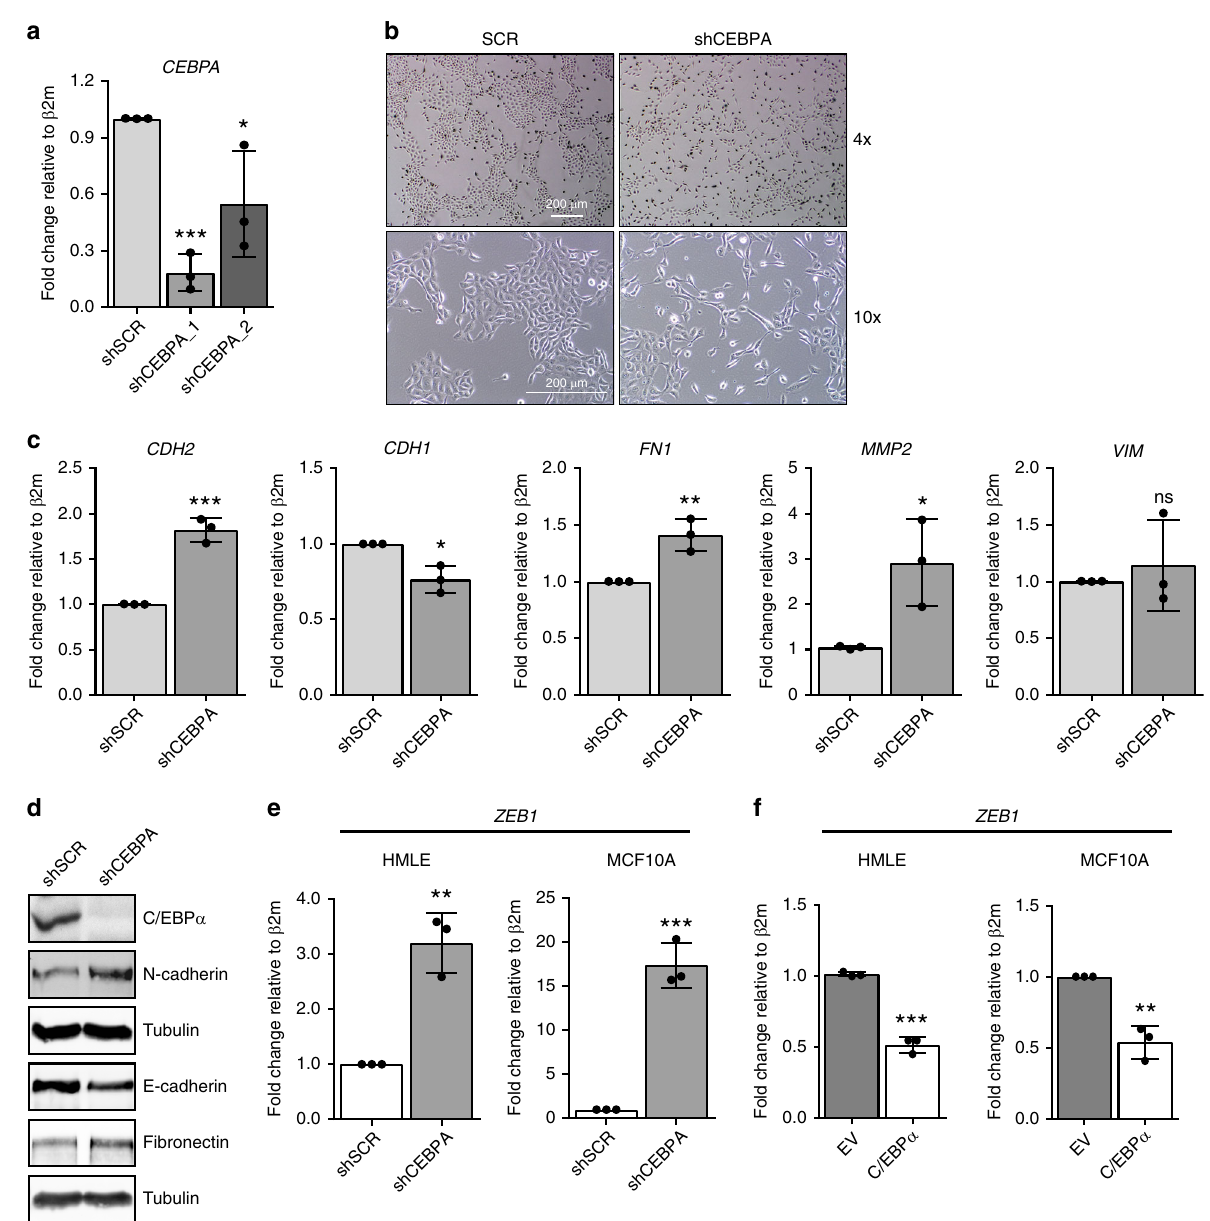
Fig. 5 Knockdown of C/EBP ɑ impairs epithelial homeostasis. a The results from qRT-PCR analysis showing CEBPA mRNA levels in HMLE cells expressing shRNA control (SCR) or HMLE cells expressing two independent shRNAs targeting CEBPA (shCEBPA_1 and shCEBPA_2). Data represented as mean ± SD of three independent experiments. p -values were calculated using unpaired two-tailed Student ’ s t test. * p < 0.05, *** p < 0.001. b Bright- fi eld microscopy images of HMLE cells expressing shRNA control (SCR) or shRNA targeting CEBPA in two different magni fi cations. Data are representative of three independent experiments. Scale bar: 200 μ m. c qRT-PCR data showing the expression levels of known epithelial and mesenchymal markers upon CEBPA knockdown in HMLE cells. Data represented as mean ± SD of three independent experiments. p -values were calculated using unpaired two-tailed Student ’ s t test. * p < 0.05, ** p < 0.01, *** p < 0.001. ns not signi fi cant. d The results from immunoblotting analysis displaying protein levels of well-characterized EMT markers upon CEBPA knockdown in HMLE cells. Data are representative of three independent experiments. e The results from qRT-PCR analysis showing the mRNA levels of transcription factor ZEB1 upon CEBPA knockdown in HMLE and MCF10A cells. Data represented as mean ± SD of three independent experiments. p -values were calculated using unpaired two-tailed Student ’ s t test. ** p < 0.01, *** p < 0.001. f ZEB1 mRNA levels in HMLE or MCF10A cells expressing EV or constitutive CEBPA . Data represented as mean ± SD of three independent experiments. p -values were calculated using unpaired